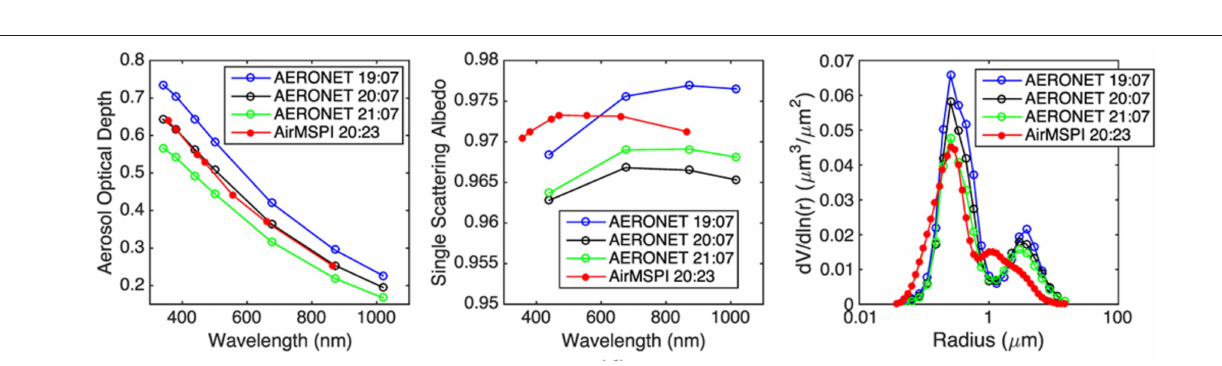
FIGURE 6 | Polarized water-leaving relative percentage contribution in the TOA polarized reflectance for the same case as Figure 4 . Reprinted with permission from Zhai et al. (2017a), The Optical Society (OSA).